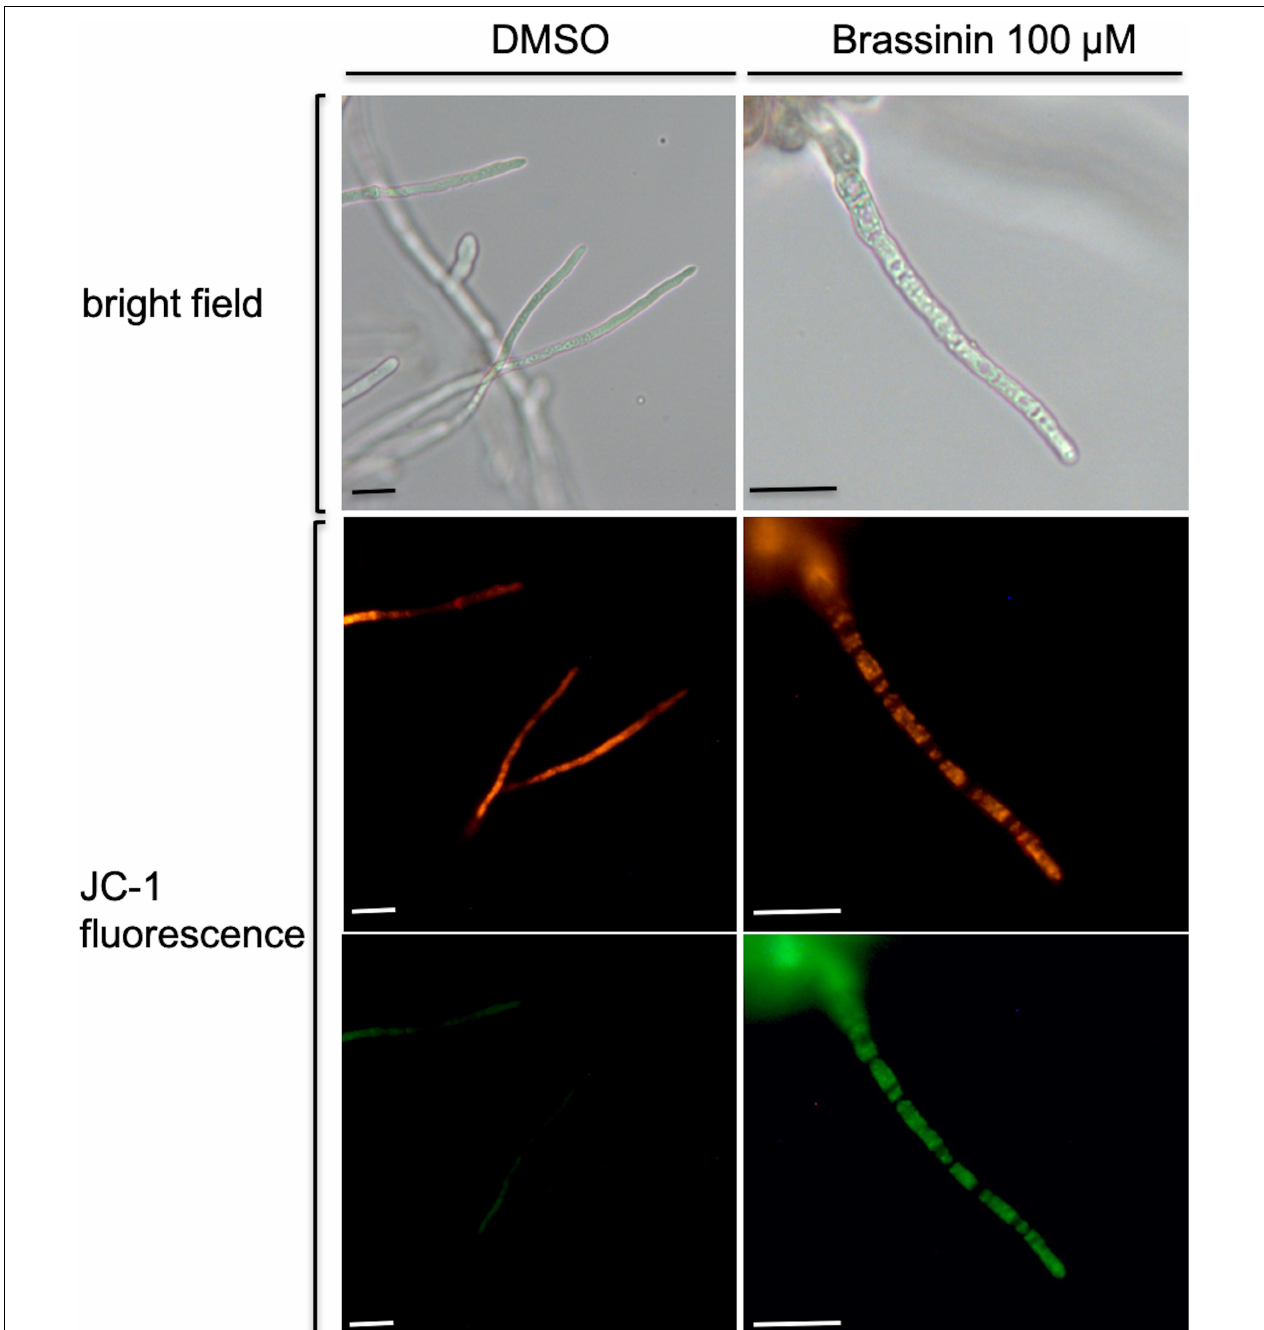
FIGURE 4 | Assessment of changes in mitochondrial membrane potentials within A. brassicicola cells exposed for 30 min to 100 µ M brassinin or to DMSO, using the fluorescent potentiometric dye JC-1. The top pictures correspond to light-field microscopy while the other pictures correspond to fluorescence microscopy. Scale bars = 20 µ